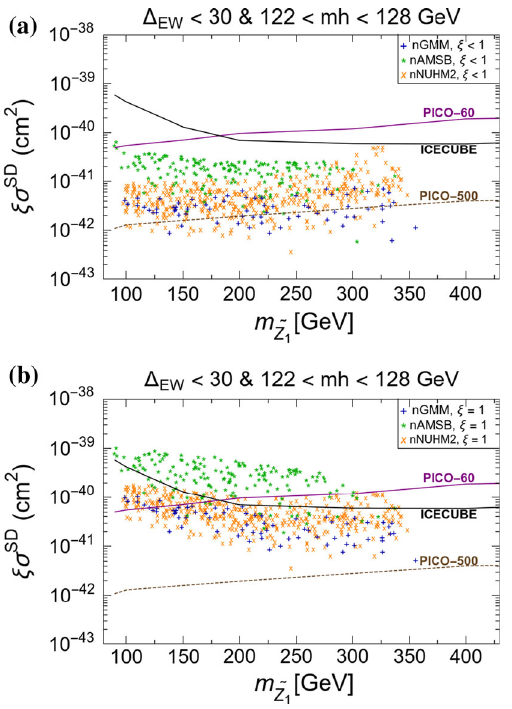
Fig. 3 Plot of points in the σ SD ( (cid:2) Z 1 p ) vs. m (cid:2) Z 1 plane from scans over the parameter space of the the natural NUHM2, nGMM and nAMSB models for a ξ < 1, assuming the neutralino relic density is given by its thermal value, and b ξ = 1